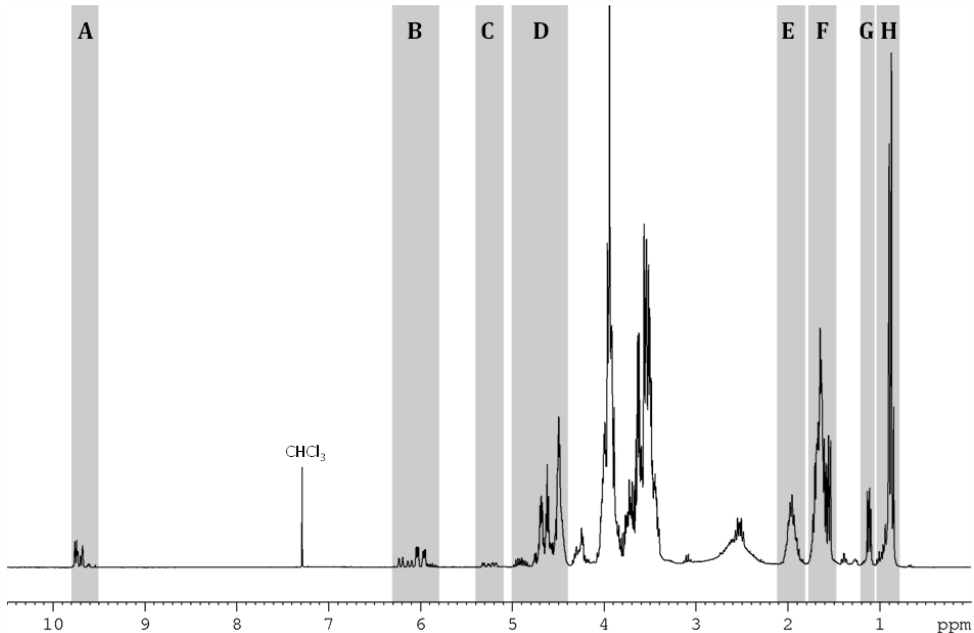
Figure 1. 1 H NMR spectrum of the final HHM reaction medium of isosorbide diallyl ether (IDE) after evaporation of triethylamine and toluene (300 MHz, CDCl 3 , 25 °C); experimental conditions: Rh(acac)(CO) 2 (12.9 mg, 50 μmol, 1 equiv), TEA (200 equiv), IDE (2.26 g, 10 mmol, 200 equiv), toluene (6 mL), 80 bars of CO/H 2 (1:1), 80 °C, 4 h; the values of integration of the different chemical shift zones (zones A to H ) were used to determine conversion and yields (see part IV.2 of Supplementary